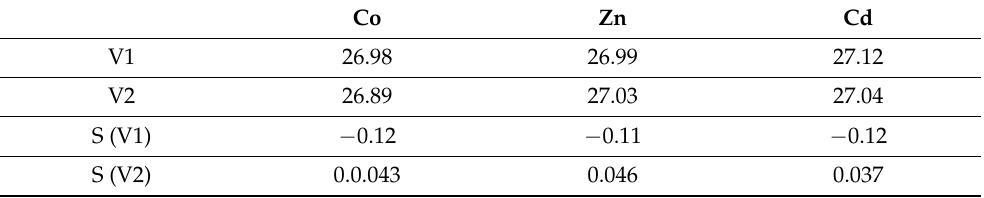
Table 2. Volumes of the VO 5 polyhedra (Å 3 ) and of the shape parameter S using the MBE